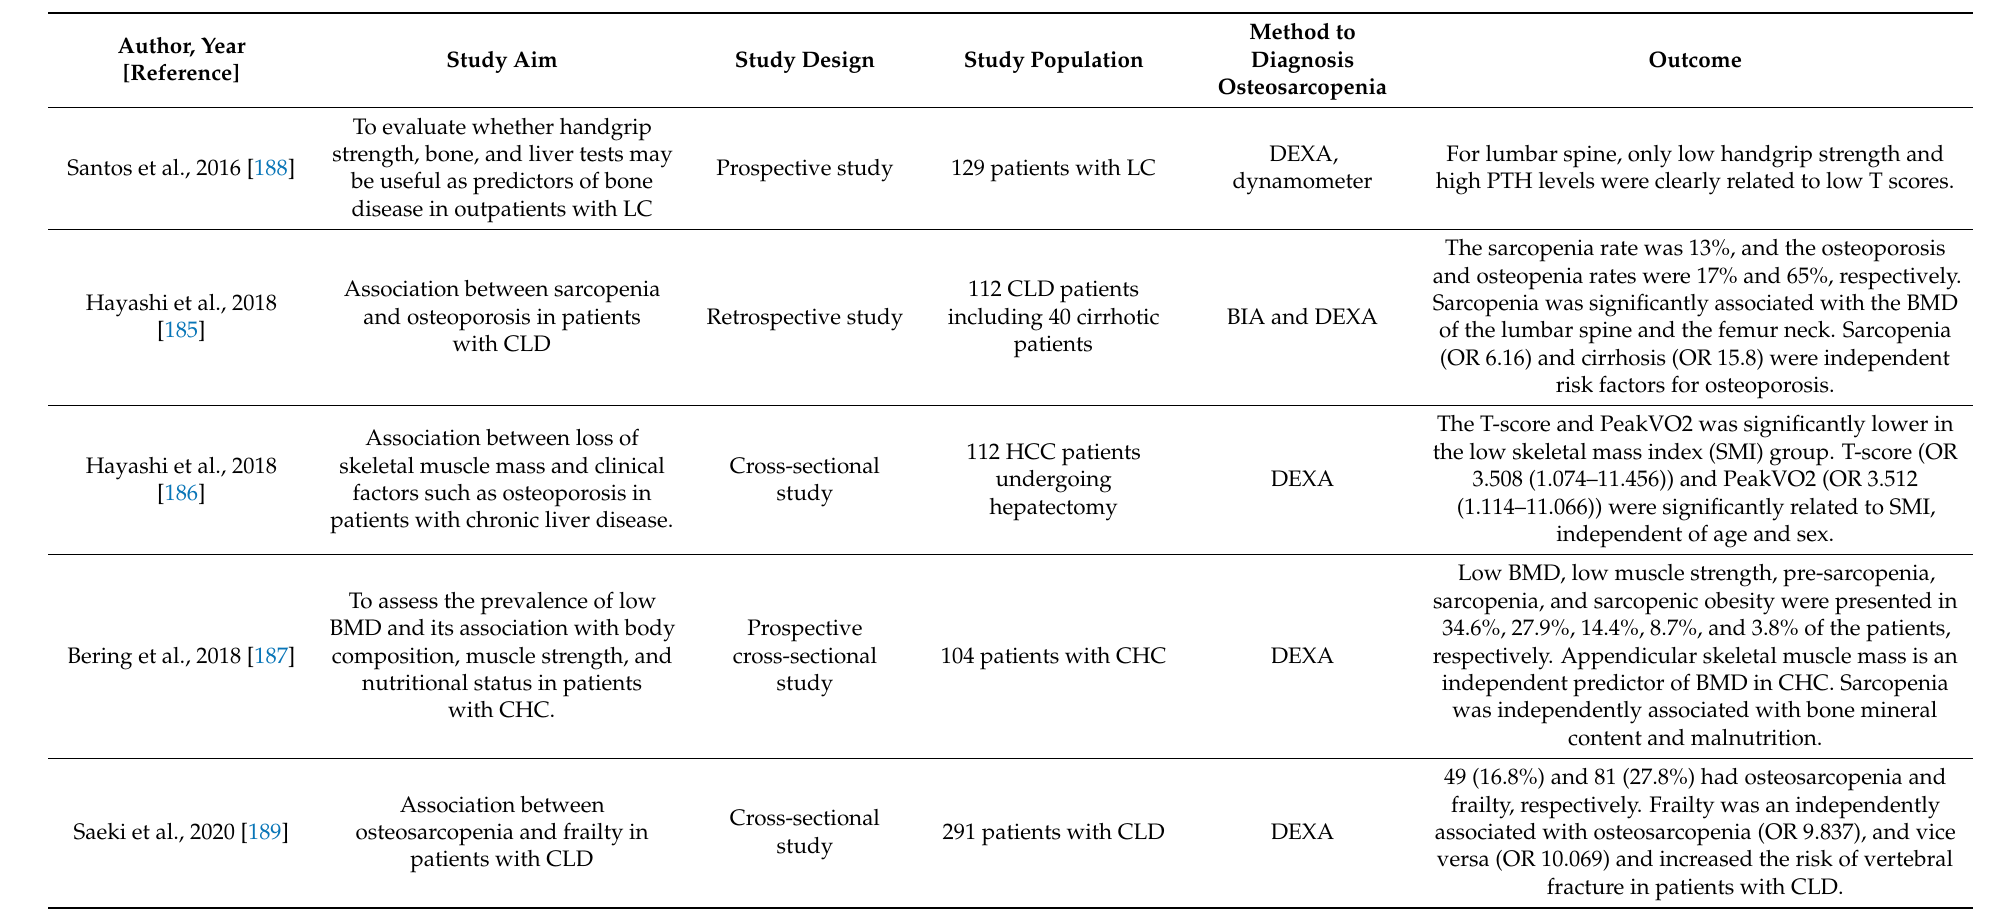
Table 3. Representative clinical studies for osetosarcopenia in chronic liver